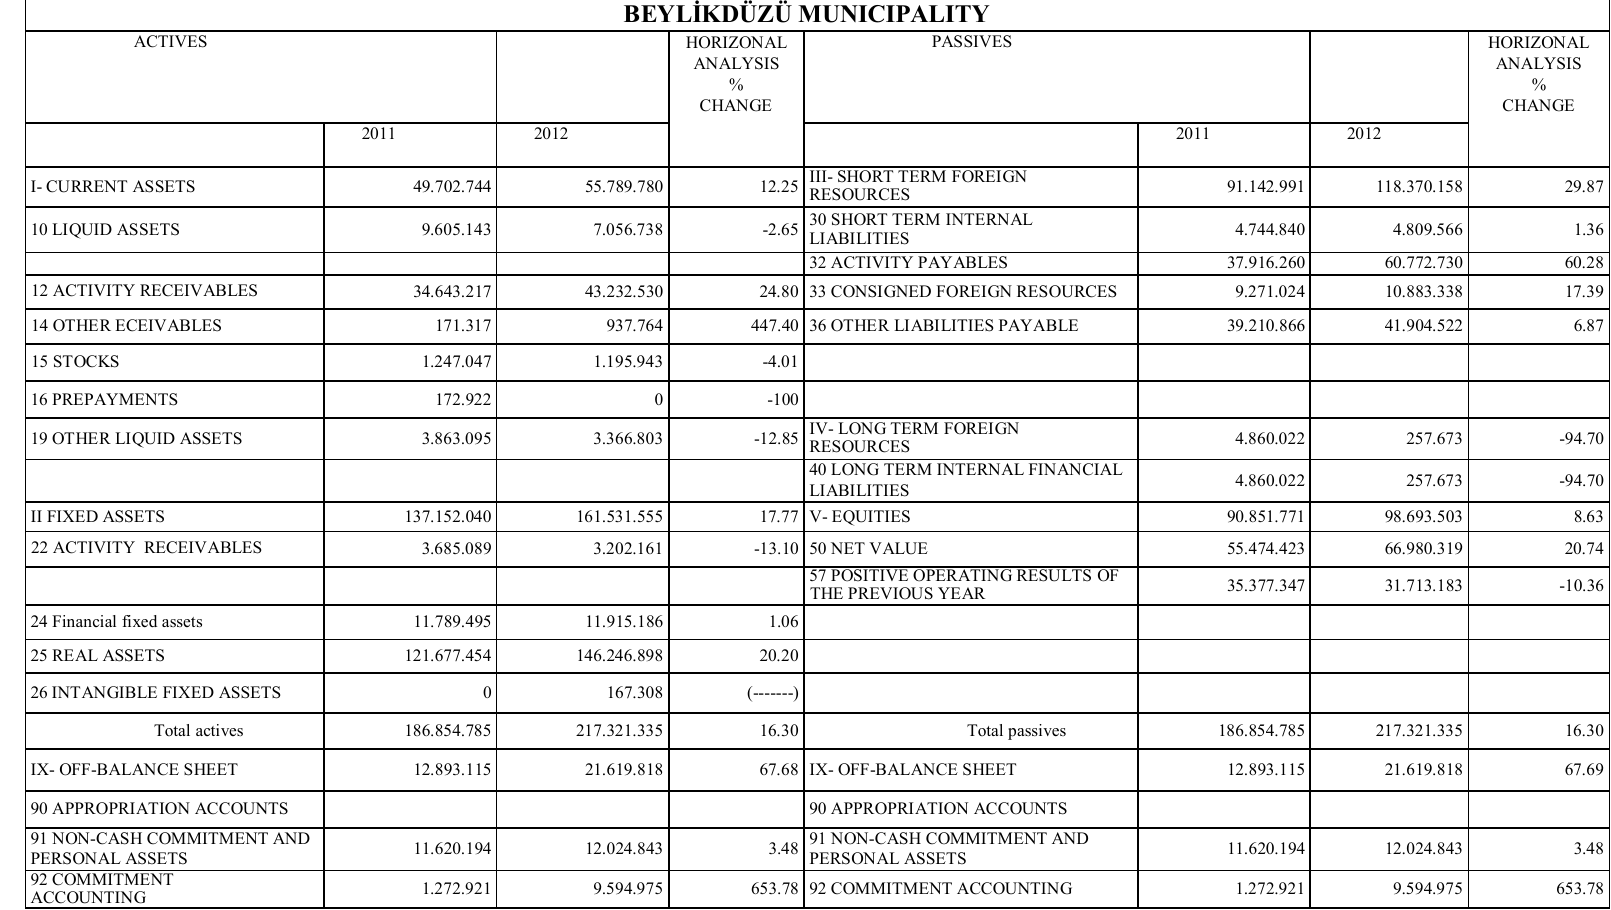
Table 1 : Comparative financial statements of the Beylikdüzü